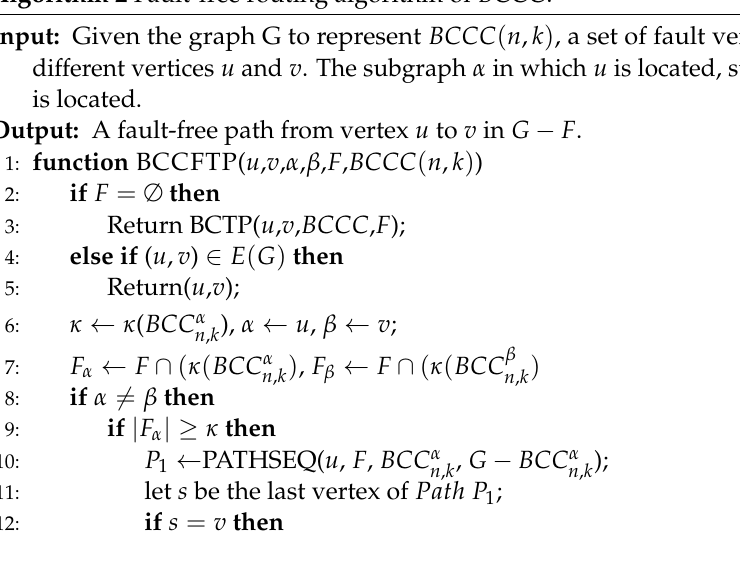
Algorithm 2 Fault-free routing algorithm of BCCC